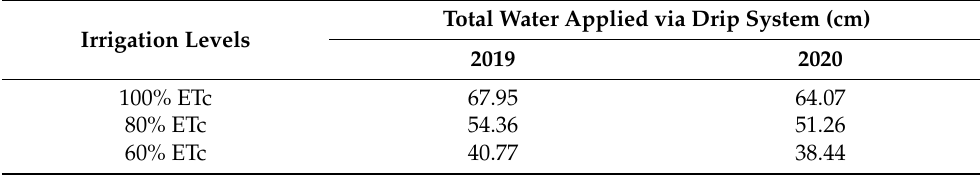
Table 2. Total amount of applied water in years 2019 and 2020 during tomato growth period in protected